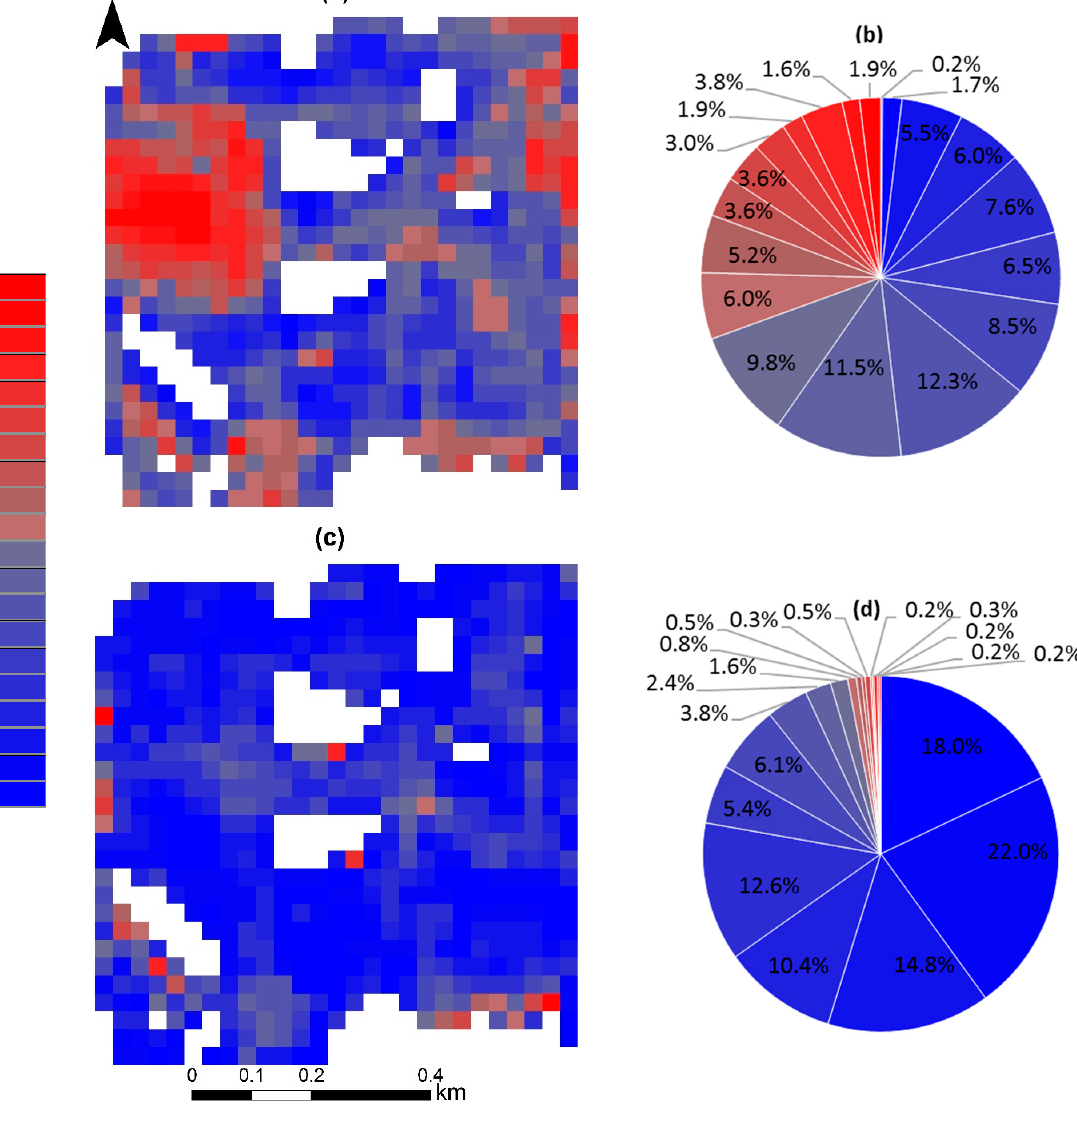
Figure 11. Pixel-by-pixel correlation between vegetation and drought (2016–2021 ( a ) and (2016–2019 ( c )) and the percentage of pixels in the correlation classes (2016–2021 ( b ) and (2016 to 2019 ( d )).